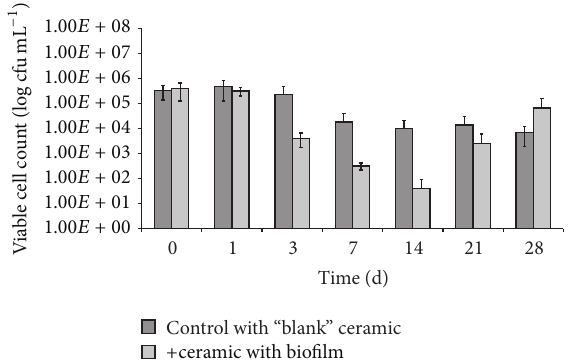
Figure 5: Logarithmic presentation of viable cell count measure- ments [cfu mL −1 ] of V. anguillarum in the presence of a P. sp. strain MLms gA3biofilmcoatedceramictileoveraperiodof28days(light grey bars). A blank ceramic tile served as the control (dark grey bars). The initial concentration of V. anguillarum was the same in both treatments ( ∼ 10 5 cfu mL −1 ; see also Table 2, 0 d